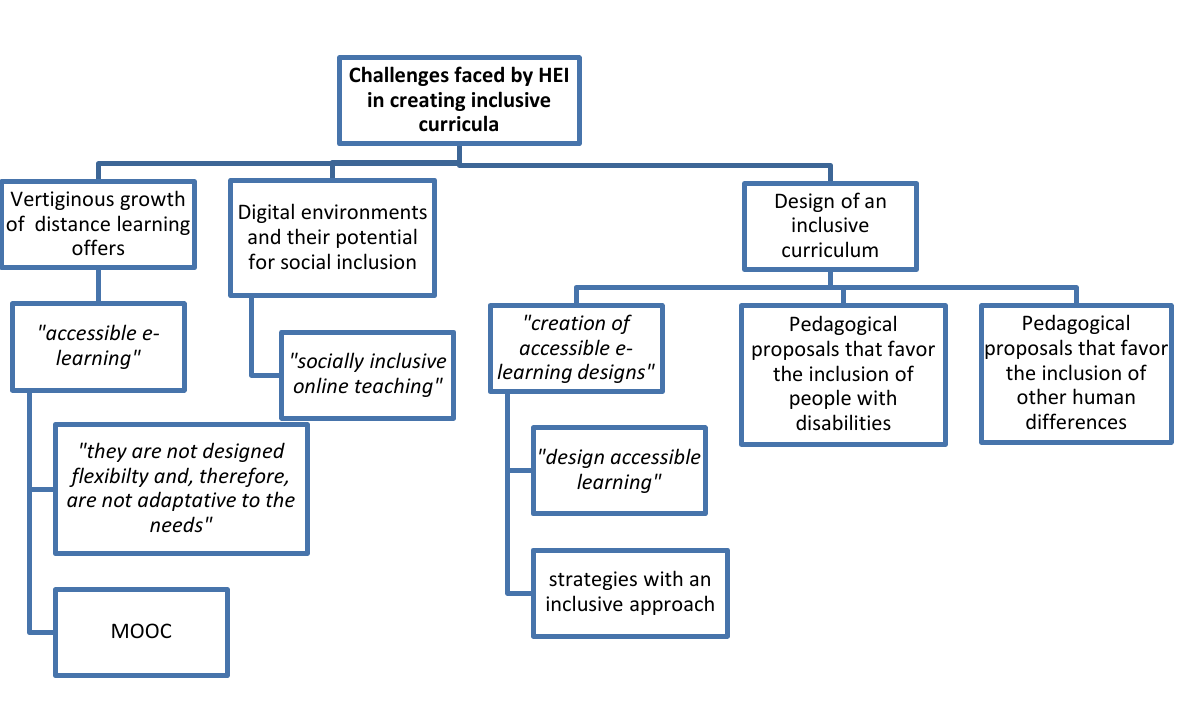
Figure 4 . Challenges faced by HEI in creating inclusive curricula. This mind map illustrates the subcategory and its properties. Some of the text is framed in quotation marks and italics, which correspond to brief textual quotations from some of the articles studied, while the others correspond to codes created by the